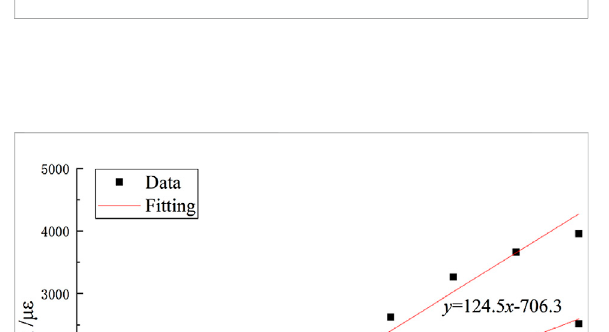
FIGURE 4 Relationship between temperature and strain of a strain gauge in a HI cell.